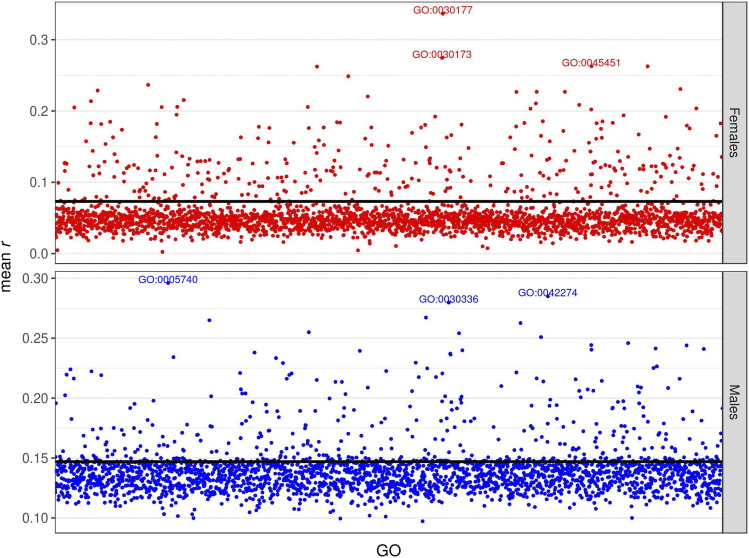
Prediction accuracy for starvation resistance, measured as mean r (on the y-axis) in the test set, obtained by the GO-GBLUP model. Each point represents the prediction accuracy achieved by a specific GO term; the top 3 most predictive GO terms are spelled out. The black horizontal line represents the accuracy of the baseline GBLUP model. The upper panel represents females, and the lower panel represents males.